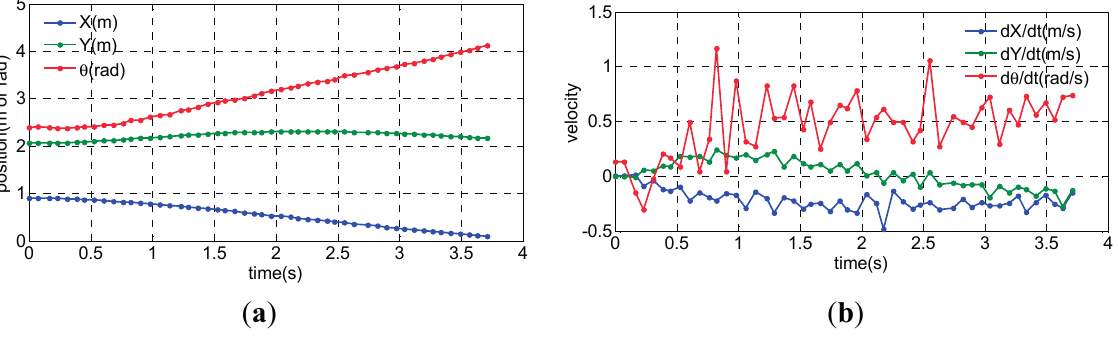
Figure 11. Position and velocity of robots calculated by the proposed algorithm. ( a ) position and heading; ( b ) velocity.